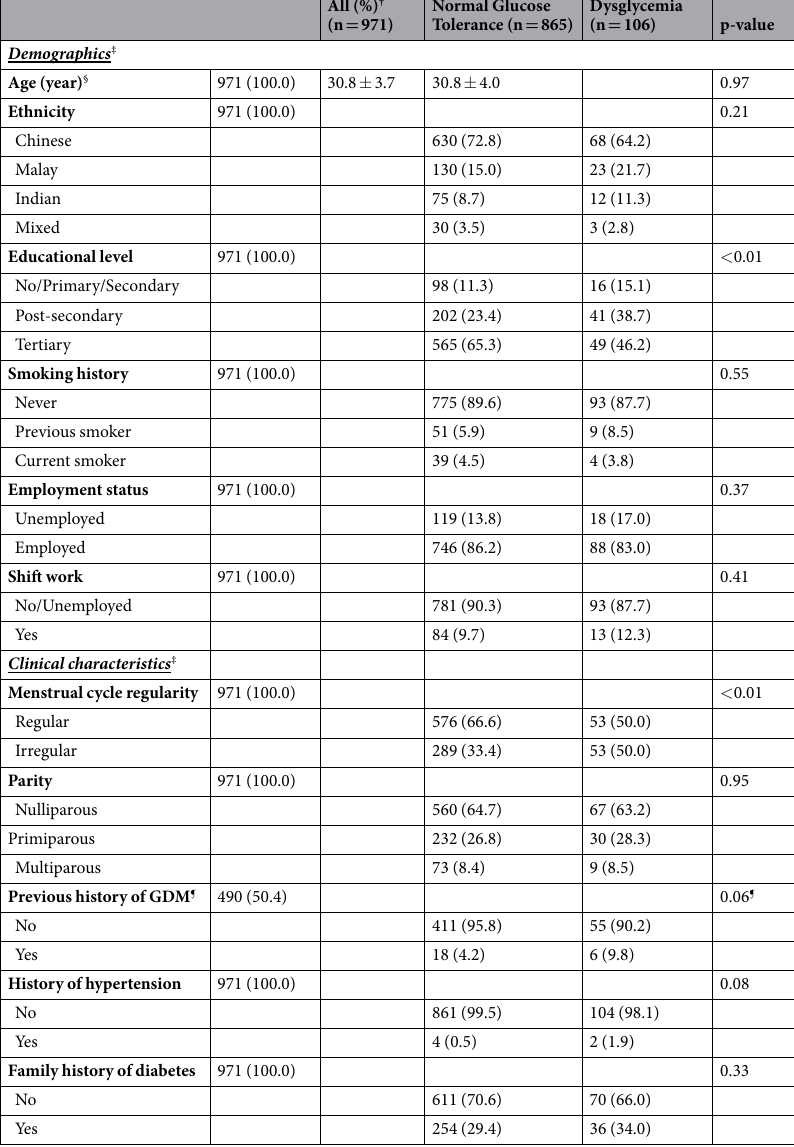
Table 1. Demographics and clinical characteristics of all women by glycemic status. † Total sample size (n) is not always 971 due to the missing values. ‡ ʹ (%). § Mean ± SD. ¶ Excluding nulliparous women. GDM, Gestational diabetes